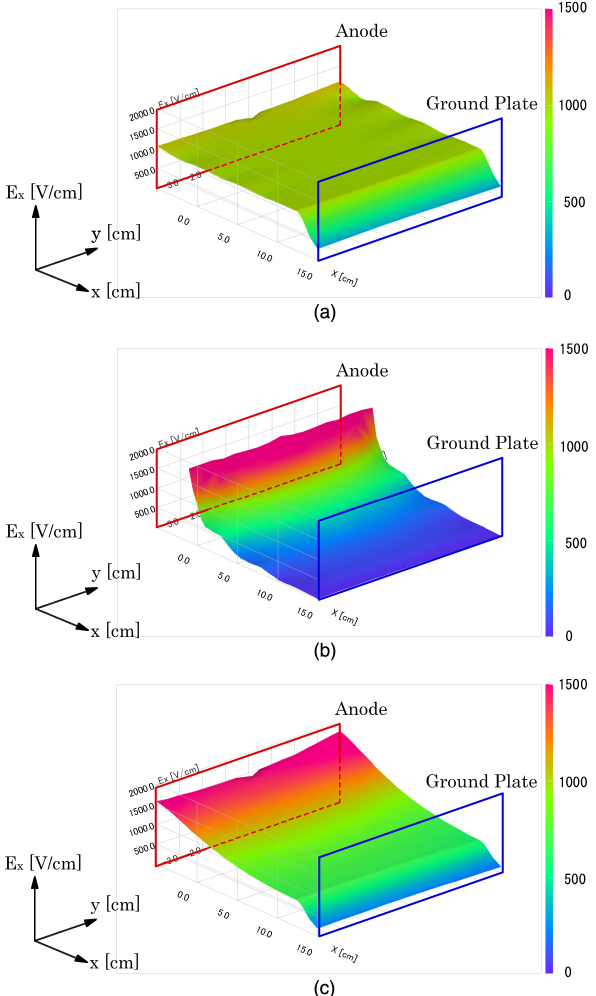
FIG. 6. (a) E x distribution on the kicker central plane at z ¼ 1150 mm for Model 0. (b) E x distribution on the kicker central plane at z ¼ 1150 mm for Model 1. (c) E x distribution on the kicker central plane at z ¼ 1150 mm for Model 2.